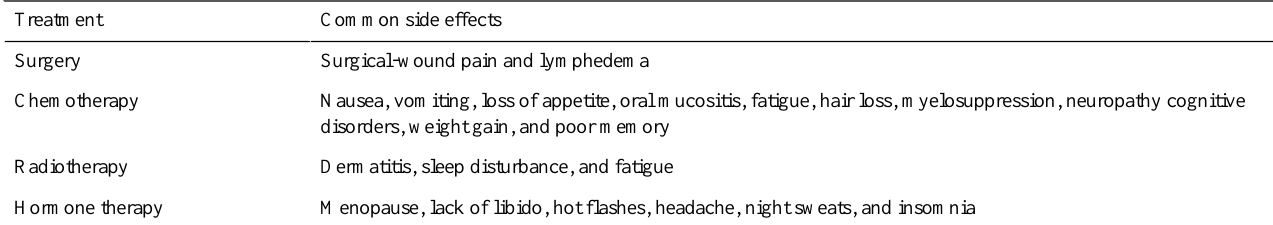
Table 1. Common side effects of breast cancer treatments, which differ by treatment